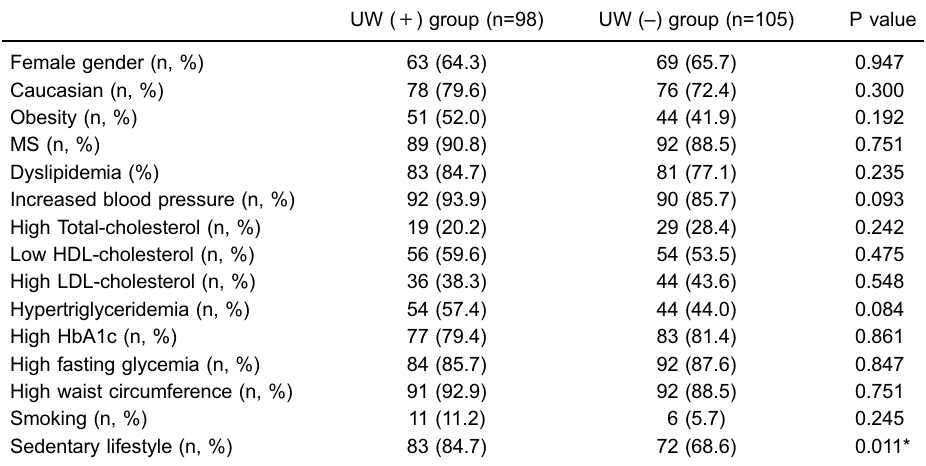
Table 2. Univariate analysis of demographic, anthropometric, and clinical characteristics of 203 patients with type 2 diabetes mellitus assessed for the presence of the symptom of unsteady walking (UW). UW ( + ) group